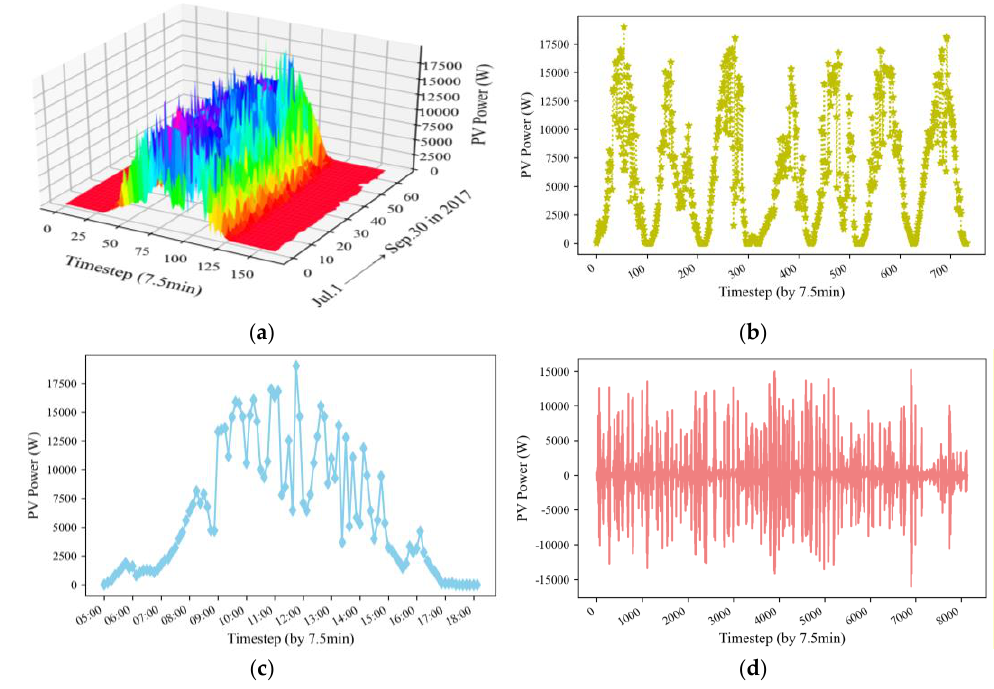
Figure 4. PV power generation data. ( a ) The whole dataset in three dimensions, ( b ) Weekly frequency for the years 1 July 2017–7 July 2017, ( c ) A detailed observation of PV power in 1 July 2017, ( d ) The first different result of the whole dataset.